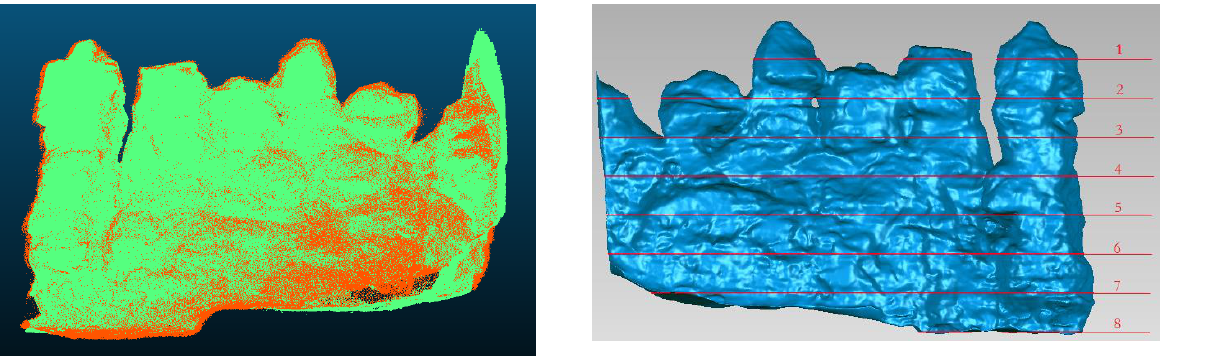
Figure 10. 3D model of the shapes and 0.2m-sections